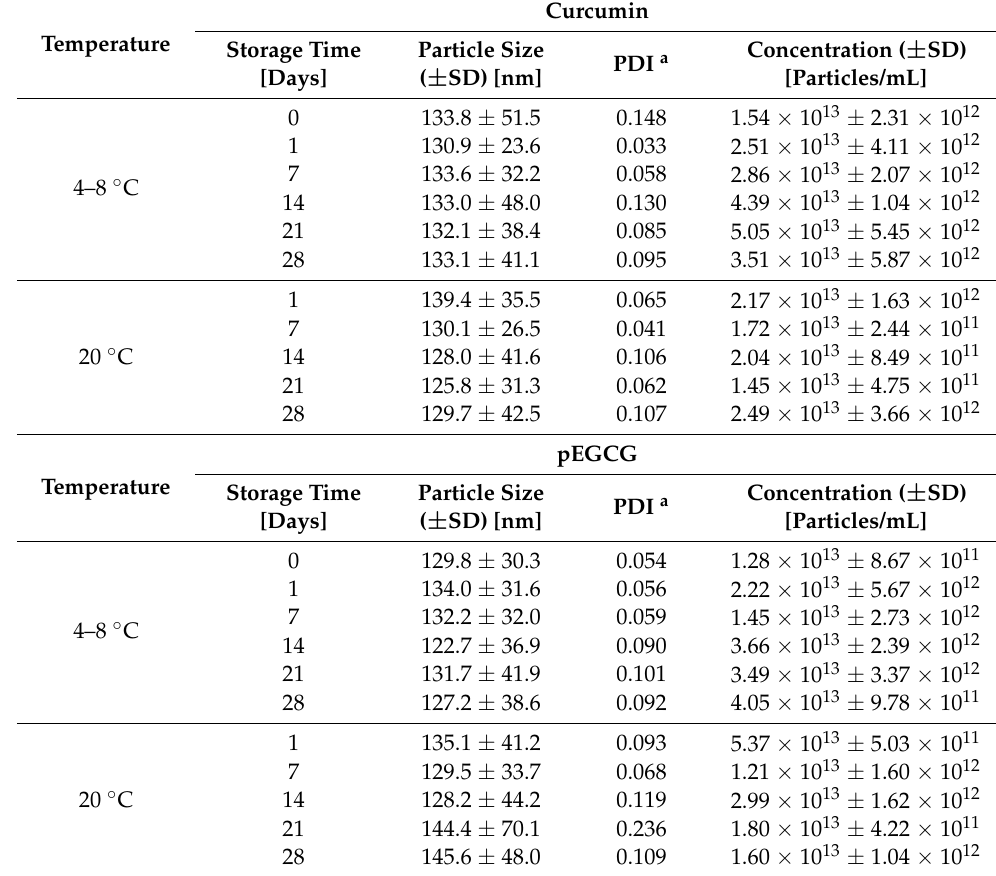
Table 2. The size of the liposomes and their concentration depending on the storage conditions and embedded